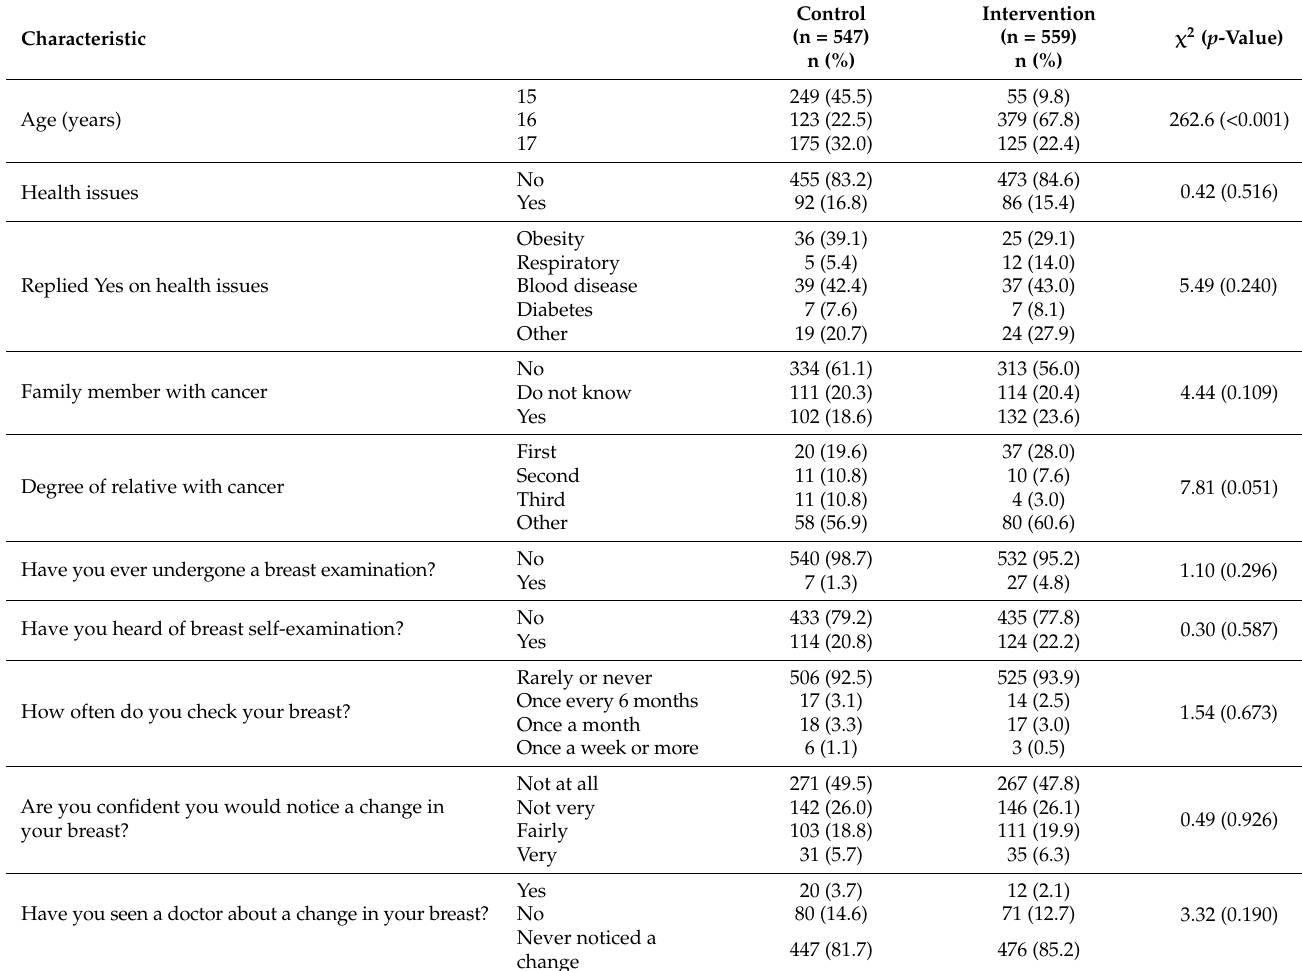
Table 1. Sociodemographic characteristics of the students (N =